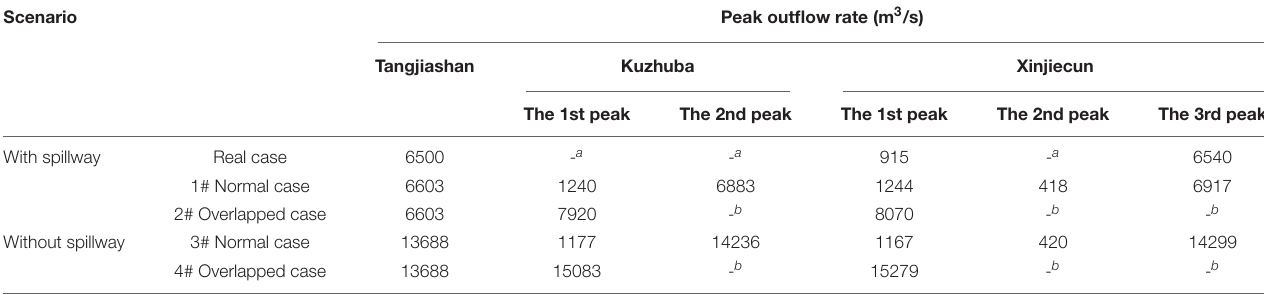
FIGURE 5 | Simulated and recorded outflow rate of the cascading breaching of the three landslide dams (T. = Tangjiashan; K. = Kuzhuba; X. = Xinjiecun) [based on Zhang (2009) and Shi et al. (2015)]. TABLE 2 | Peak outflow rates of the cascading breaching in four scenarios by considering the constructed spillway and the flood overlapping effect.